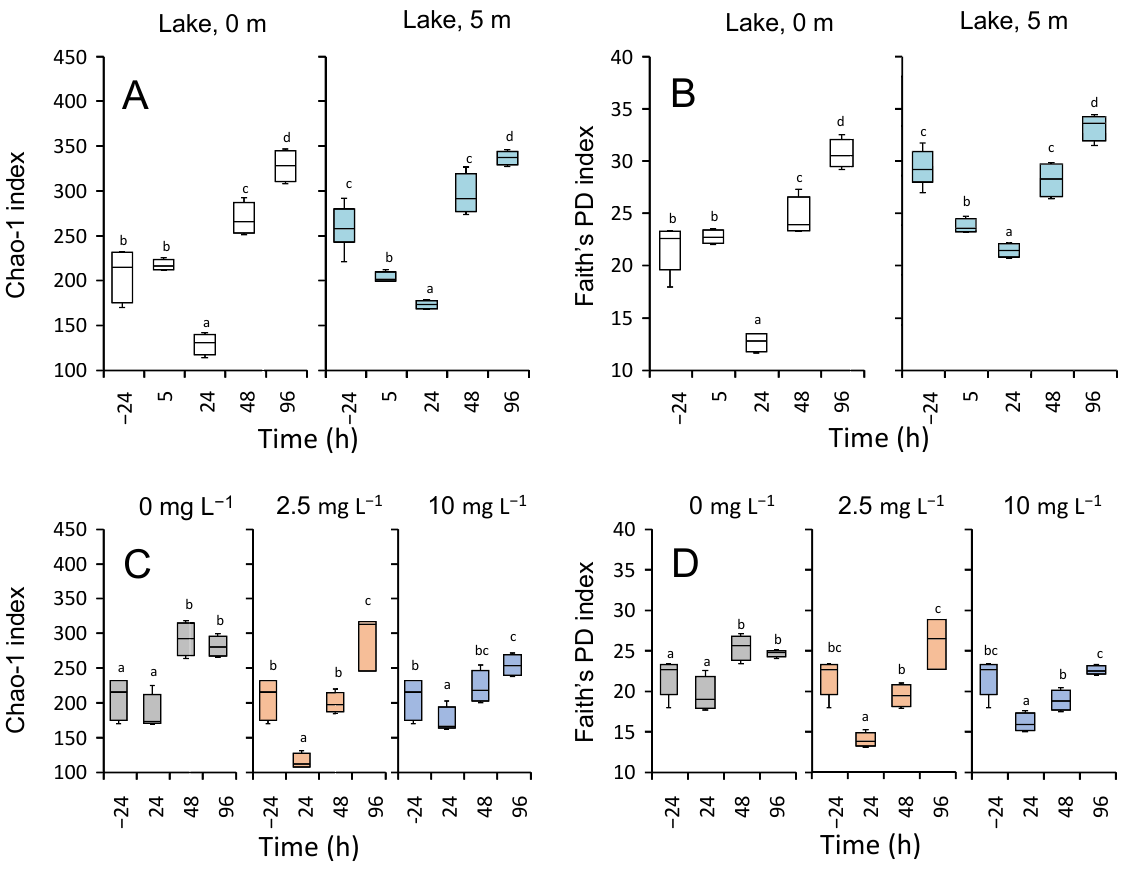
Figure 7. Alpha diversity of the microbial community during the H 2 O 2 treatment in August. ( A , C ) The Chao-1 index (estimated species richness), and ( B , D ) Faith’s phylogenetic diversity during ( A , B ) the lake treatment and ( C , D ) the incubation experiments in August. The color of the box plots indicates ( A , B ) the sampling depth in the lake or ( C , D ) the different H 2 O 2 treatment concentrations of the incubations. The horizontal lines within the box plots represent the median, the boxes—the 25% quartile and the 75% quartile, error bars—the minimum values and the maximum values. The first box plot in each panel represents the alpha diversity in the lake prior to the incubation experiments (t = − 24 h, with n = seven biological replicates). Box plots of all the subsequent time points are based on n = four biological replicates. Box plots with different letters indicate significant differences between time points according to pairwise Kruskal–Wallis